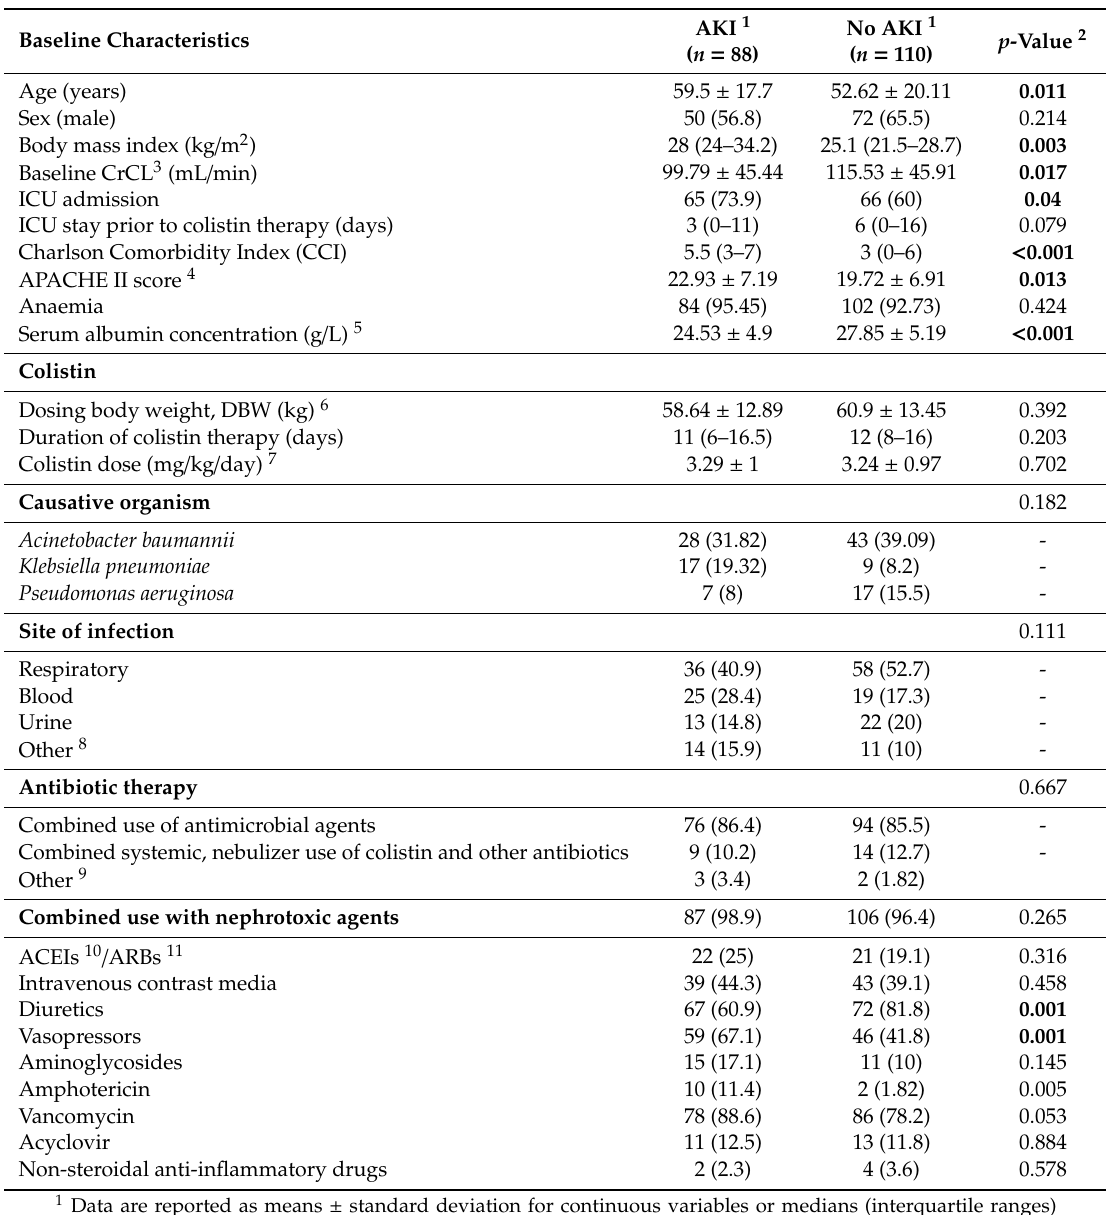
Table 1. Baseline